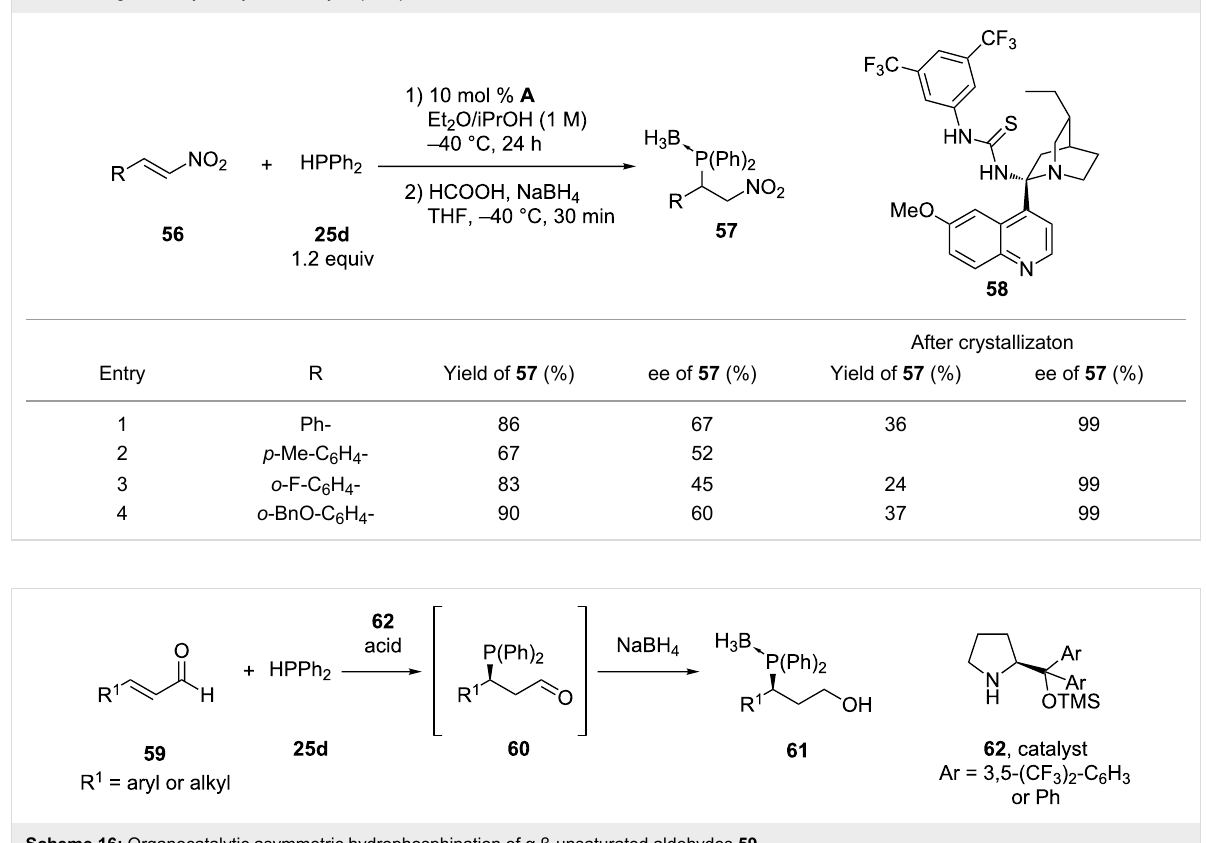
Table 5: Organocatalytic asymmetric hydrophosphination of nitroalkenes 56 .